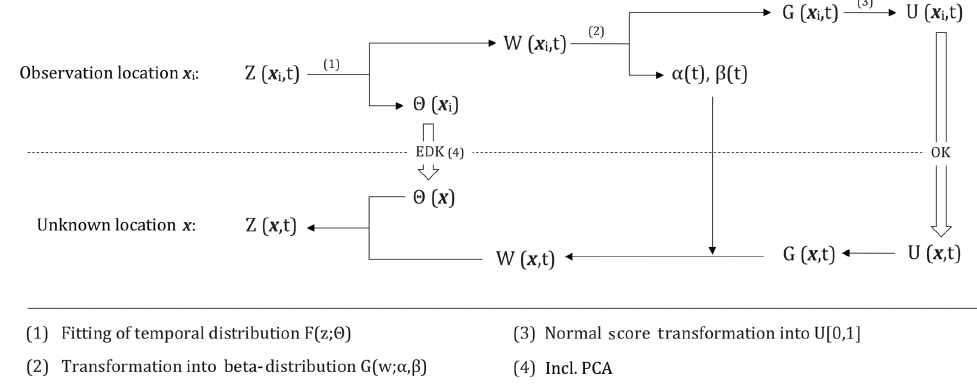
Figure 2. Flowchart for the basic methodology of quantile